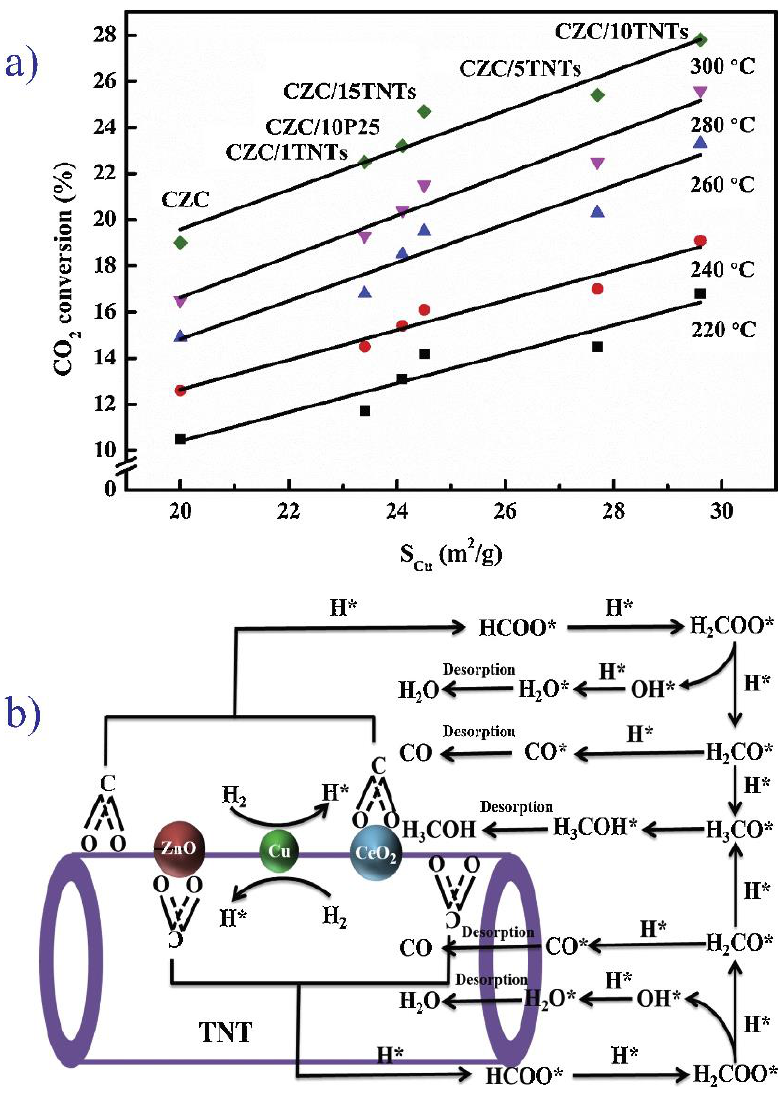
Figure 7. Role of TNT-supported CuO-ZnO-CeO 2 (CZC) catalyst: ( a ) CO 2 conversion rate versus Cu surface area (S Cu ) for various catalysts, and ( b ) possible bifunctional CO 2 hydrogenation mechanism for CH 3 OH production, adopted from [88].